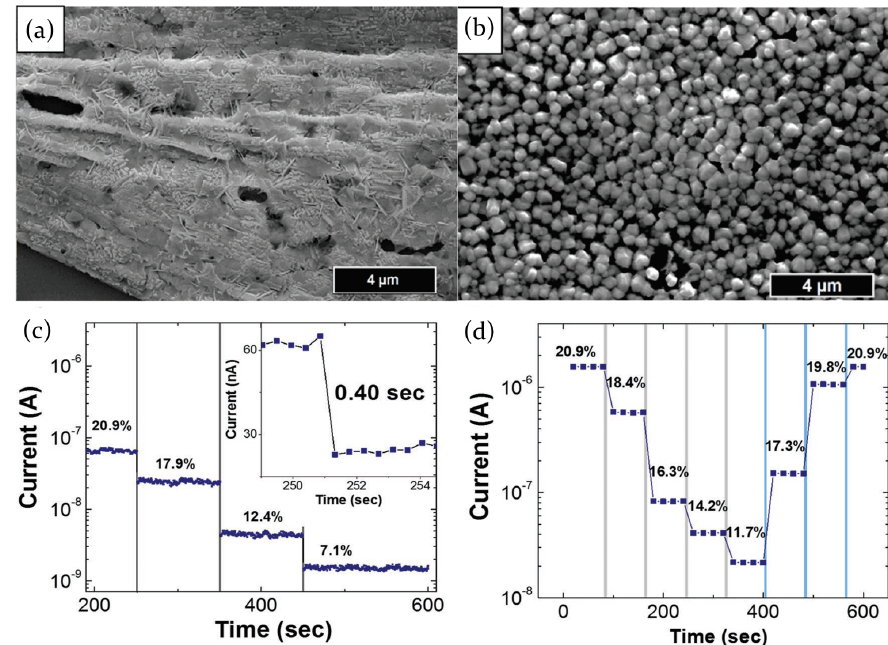
Figure 15. SEM images of ( a ) 1S sample and ( b ) 2S sample of MAPbI 3 polycrystalline films, showing the different morphologies coming from the deposition technique used. ( c ) Current change at decreasing oxygen levels. Inset: magnification of the current plot showing the response time of the device. ( d ) Current plot highlighting the reversibility of the sensor for decreasing (from 20.9% to 11.7%) and then increasing (from 11.7% to 20.9%) O 2 gas concentration. Adapted with permission from [66]. Copyright © 2017, WILEY-VCH Verlag GmbH and Co. KGaA,